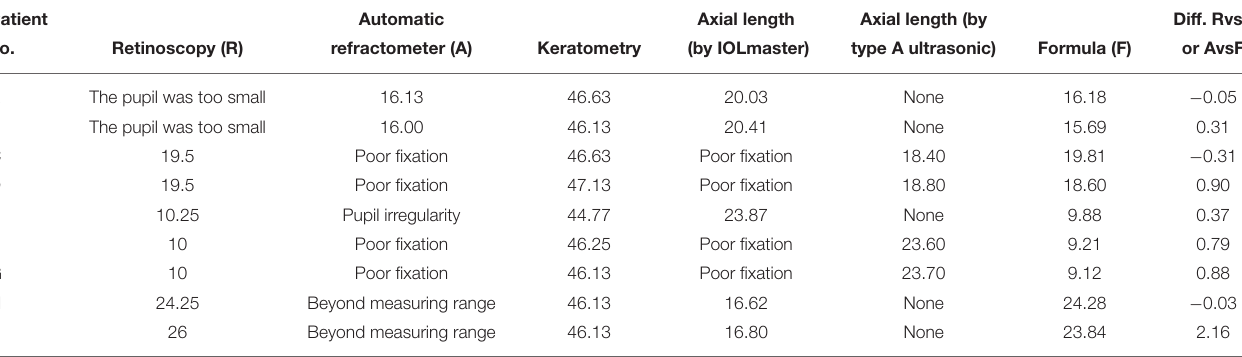
Patient Automatic Diff.